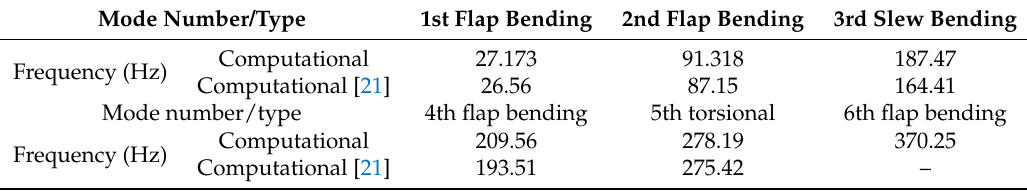
Table A6. Modal types and frequencies for the HiReNASD